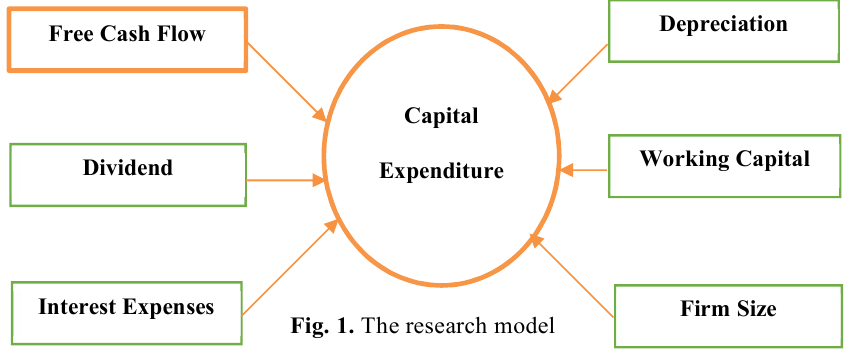
Fig. 1. The research